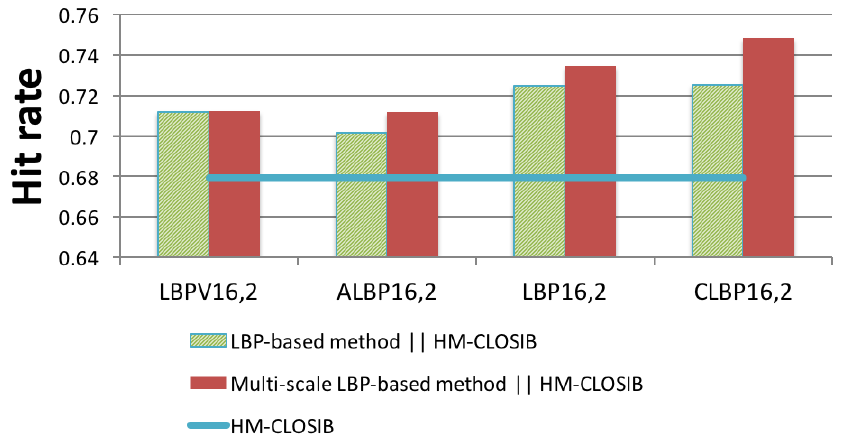
Figure 10. Hit rates obtained with the concatenation of multi-scale LBP-based descriptors and HM-CLOSIB. The horizontal line represents the hit rate of HM-CLOSIB descriptor. CLBP 16,2 (cid:102) HM-CLOSIB outperformed the rest of the 16,2,1 (cid:102) 16,2,2 (cid:102) 16,3,1 (cid:102) 16,3,2 (cid:102) 16,4,1 (cid:102) 16,4,2